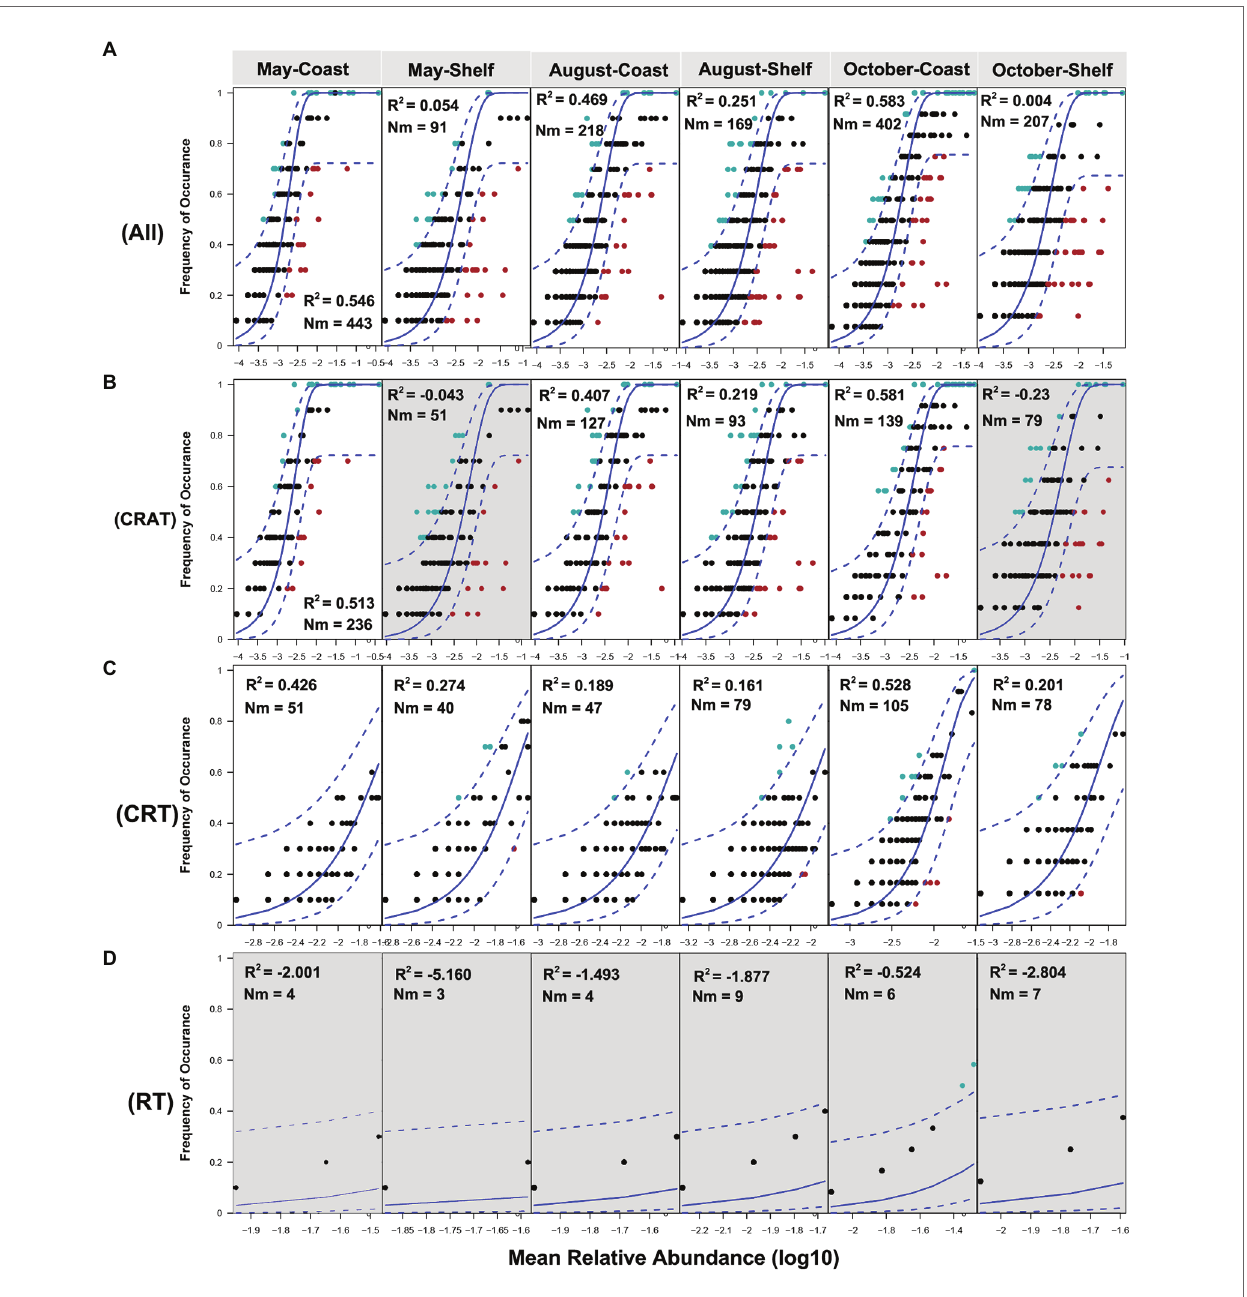
FIGURE 7 | Fit of the neutral model of community assembly. The predicted frequencies of OTUs from the set of the whole community ( A . All), CRAT (B) , CRT (C) , and RT (D) sub-communities in coastal and shelf areas in 3 months are displayed, respectively. The solid blue lines indicate the best fit to the NM and dashed blue lines represent 95% CIs around the model prediction. OTUs that occur more or less frequently than predicted by the NM are shown in different colors. Nm indicates the size of the metacommunity ( N ) times immigration rate ( m ), R 2 indicates the fit to the Nm . Note that the datasets with negative R 2 value indicate no fit to the neutral model, of which the backgrounds are in